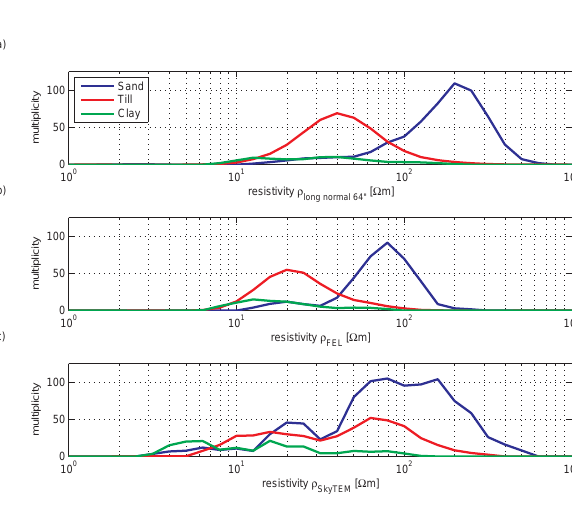
Fig. 6. Histogram of resistivity values from borehole logs and pro- jected SkyTEM resistivity values for petrographical classification of sand, till and clay: (a) long-normal 64”; (b) FEL; and (c) 6- layer model of constrained SkyTEM data. Bins are logarithmically equidistant.